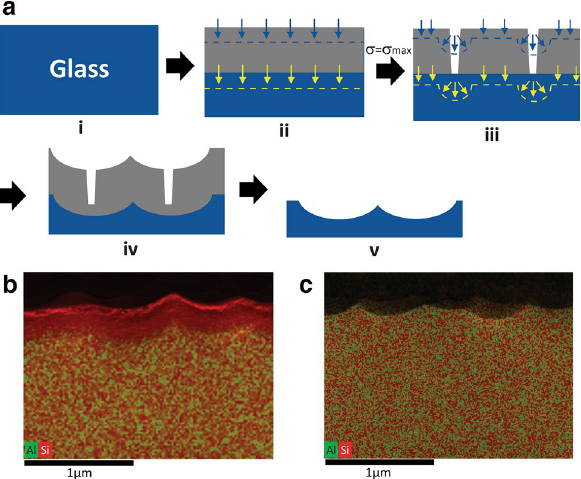
Figure 1. Mechanism of differential leaching and texturing of silicate glass. ( a ) Process flow and glass surface evolution through differential leaching and texturing. Structure i represents a 2D cross-section of a silicate glass. During leaching, the glass surface starts to develop a uniform silica leaching layer marked in grey color in structure ii. The yellow arrows indicate the direction of uniform leaching. The blue arrows are the direction of uniform silicate dissolution. The grey leaching contains a surface stress value (σ). When surface stress (σ) equals to the critical pore formation stress (σ max ), critical pores are generated through the leach layer as shown in Structure iii. The formation of the critical pores initiates the differential leaching and silica dissolution. The directions of differential leaching and silica dissolution are indicated by the yellow and blue arrows in structure iii, respectively. In this step, textures are developed at both leach layer surface and the bulk glass beneath the leach layer (structure iv). The leach layer can be removed by a high-pH treatment, which reveals the textured glass surface (structure v). ( b ) SEM/EDS image of cross-section of an aluminosilicate glass (Glass A) after differential leaching in 20 wt% citric acid at 95 °C for 10 h. The scale bar of this image is 1 micron. In the EDS map, Si elements are marked in red and Al elements in green. The top surface shows a textured silica leaching layer of about 300 nm. The bulk glass (with both Si and Al) beneath the leaching layer also possesses textures. The glass surface structure is the same as structure iv described in process a. ( c ) The textured glass (characterized in image ( c )) was further washed in pH 12 NaOH solution at 60 °C for 2 min to remove the leaching layer. The cross-section of the revealed textured surface was characterized by SEM/EDS (with 1-micron scale bar). The uniform distribution of Al and Si elements indicates the leaching layer is completely removed during the washing